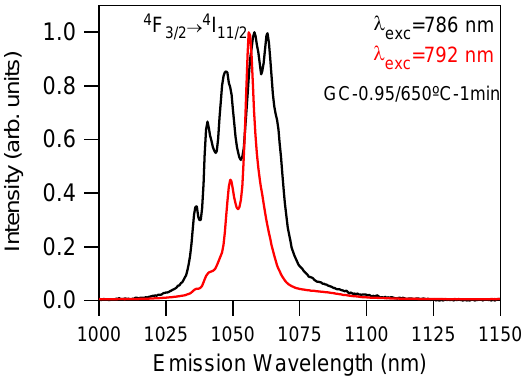
Figure 5. Room-temperature-normalized emission spectra of the 4 F 3/2 → 4 I 11/2 laser transition ob- tained under excitation at 786 (black) and 792 nm (red) for the GC-0.95 sample doped with 0.1 mol% of Nd 3+ .